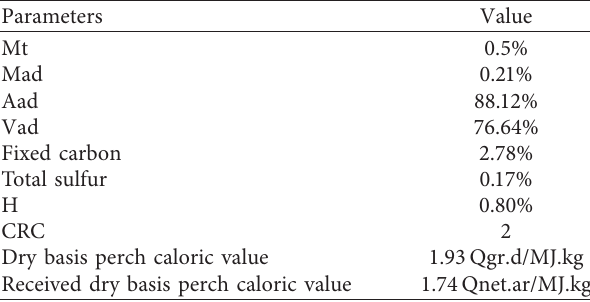
Table 3: Main parameters of coal gangue.